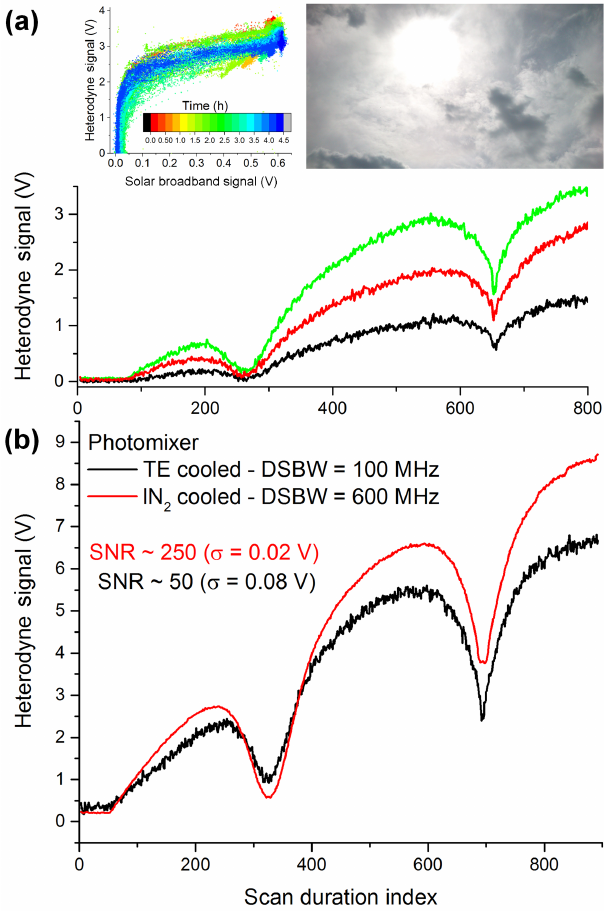
Figure 8. (a) LHR atmospheric spectra recorded for three different levels of cloud attenuation (at 60MHz spectral resolution and with 50ms integration time). The insets show a picture of the sky during the measurements and a scatterplot of NIR solar broadband ver- sus heterodyne signal, constructed using a number of constant fre- quency recordings with variable cloud amounts and types. (b) Spec- tra obtained with two different types of photomixers. The liquid N 2 -cooled photomixer with 600MHz double side bandwidth has primarily been used for this work and is compared to a thermo- electrically (Peltier) cooled photodiode with 100MHz double band bandwidth (approximate measured detector bandwidth is 100MHz, giving a SSBW of 50–100MHz after convolution with the RF fil-